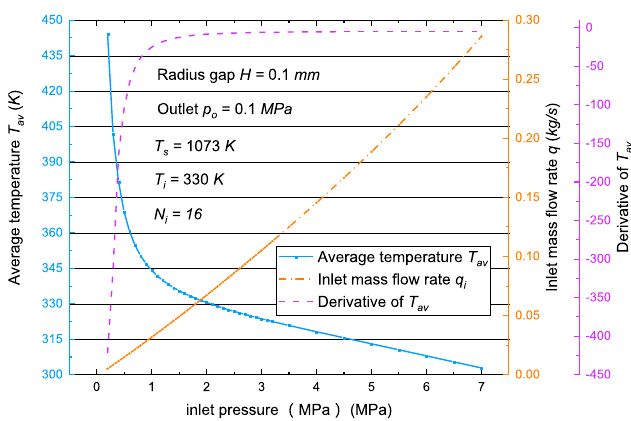
Fig. 20. Average temperature distribution of free end vs inlet pressure for 16-jet.